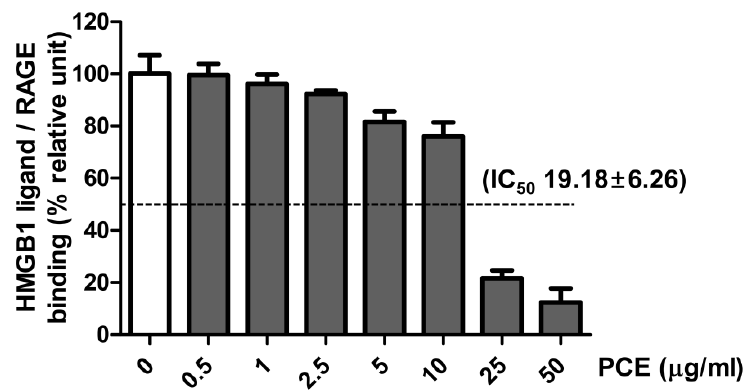
Figure 6. Effect of PCE on the binding of the HMGB1 ligand to its receptor (RAGE). The experiments were performed in quadruplicate. All data are expressed as the mean ± SEM.